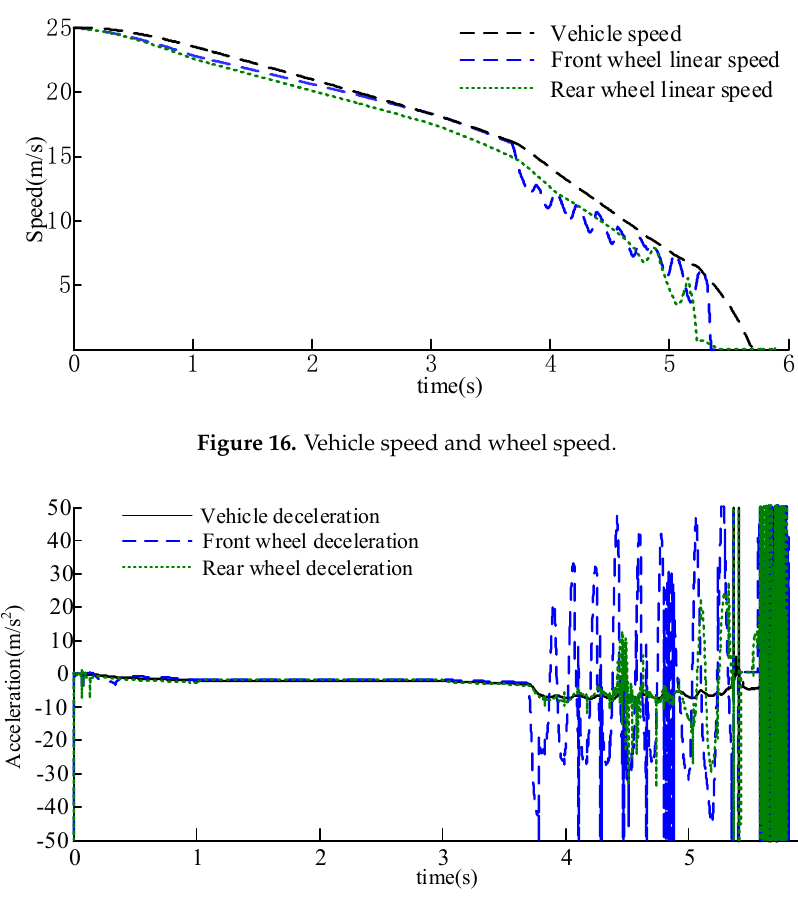
Figure 17. Vehicle and wheel deceleration.